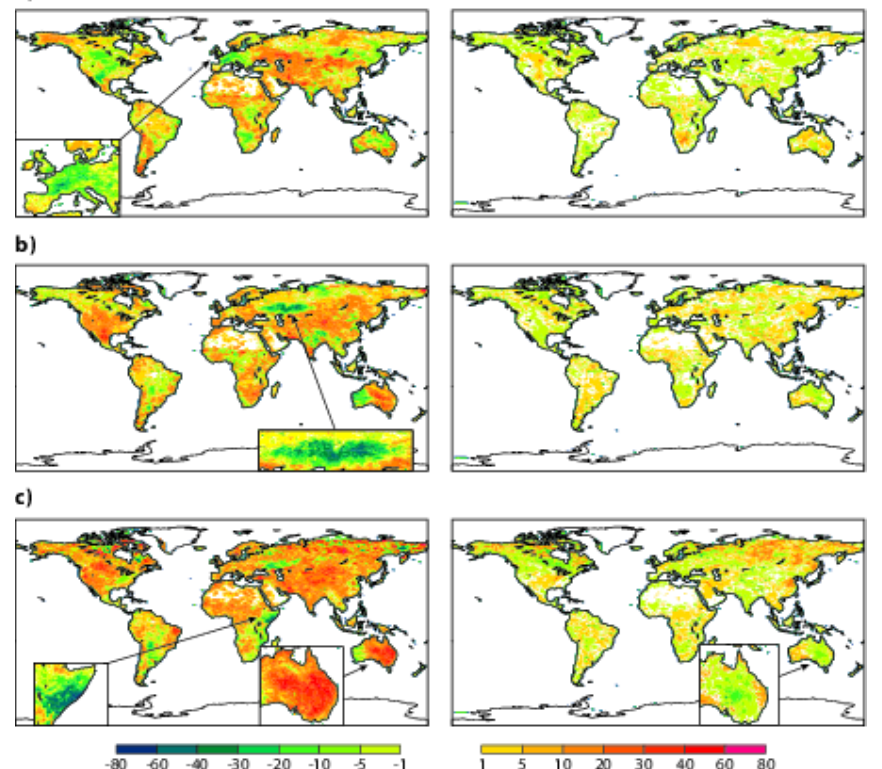
Figure 11. Relative anomaly [%] with respect to mean (1999–2012) climate of Leaf Area Index (LAI) ( left ) and broadband diffuse albedo ( right ) for ( a ) August 2003; ( b ) July 2010 and ( c ) November 2010. Regions of interest are zoomed